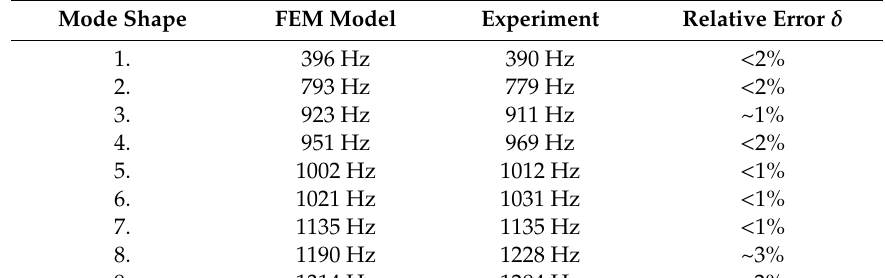
Figure 13. Comparison of selected calculated and experimentally determined mode shapes for the complex steel–polymer concrete frame.